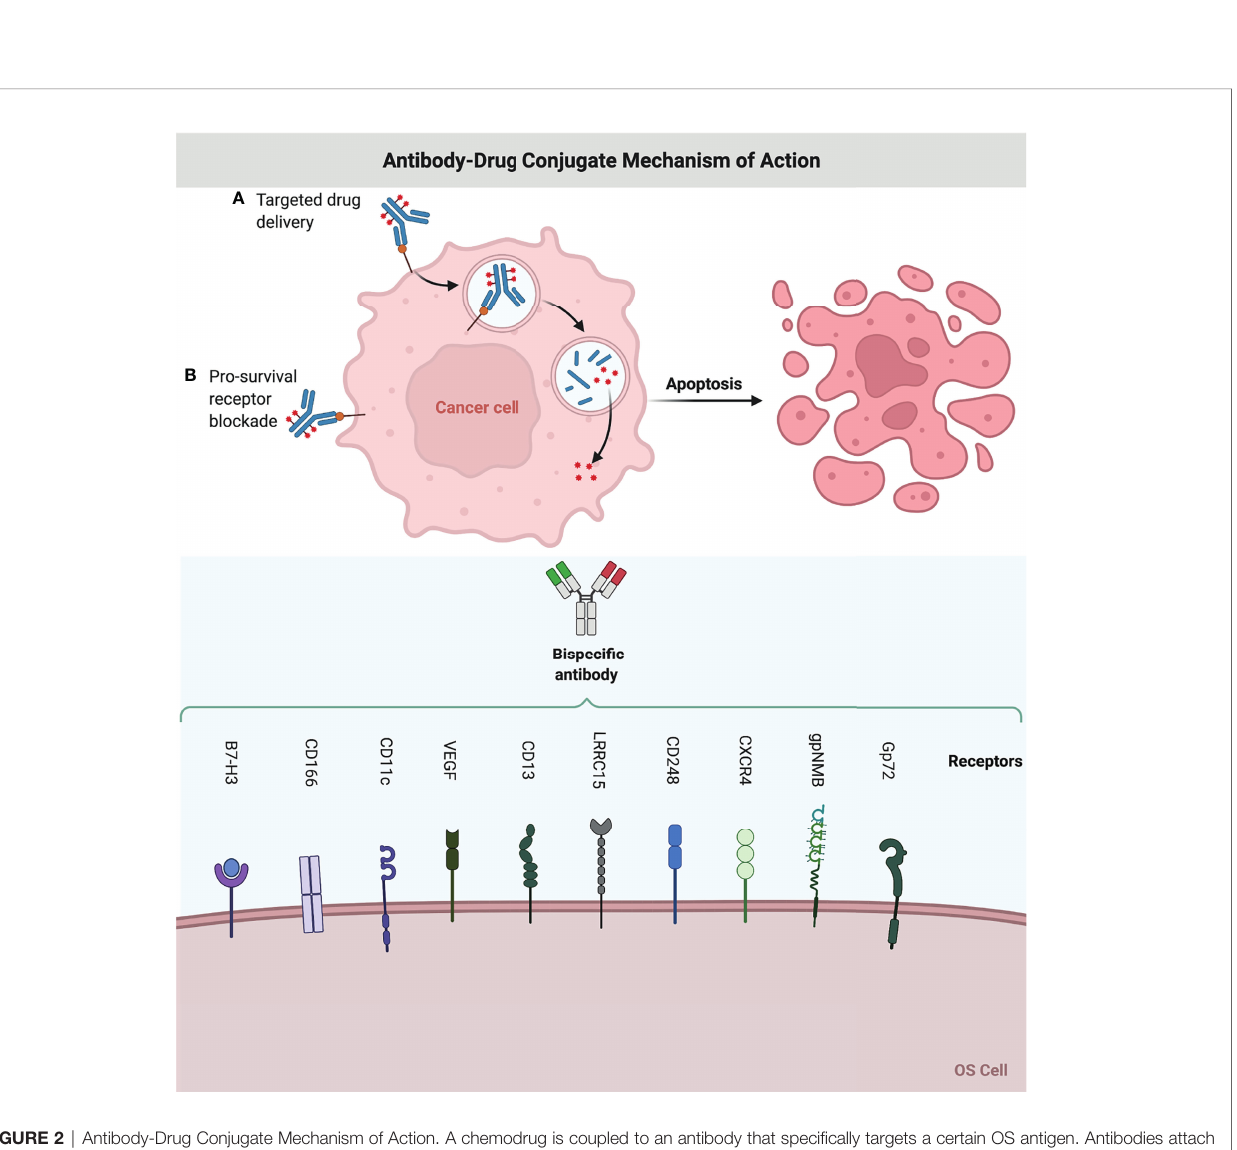
FIGURE 2 | Antibody-Drug Conjugate Mechanism of Action. A chemodrug is coupled to an antibody that speci fi cally targets a certain OS antigen. Antibodies attach themselves to the antigens on the surface of cancerous cells. The biochemical reaction between the antibody and the target protein (antigen) triggers a signal in the OS cell, which then inhibits OS cell growth, or internalizes the antibody together with the linked chemo drug and eliminates the OS cell. This fi gure was created with